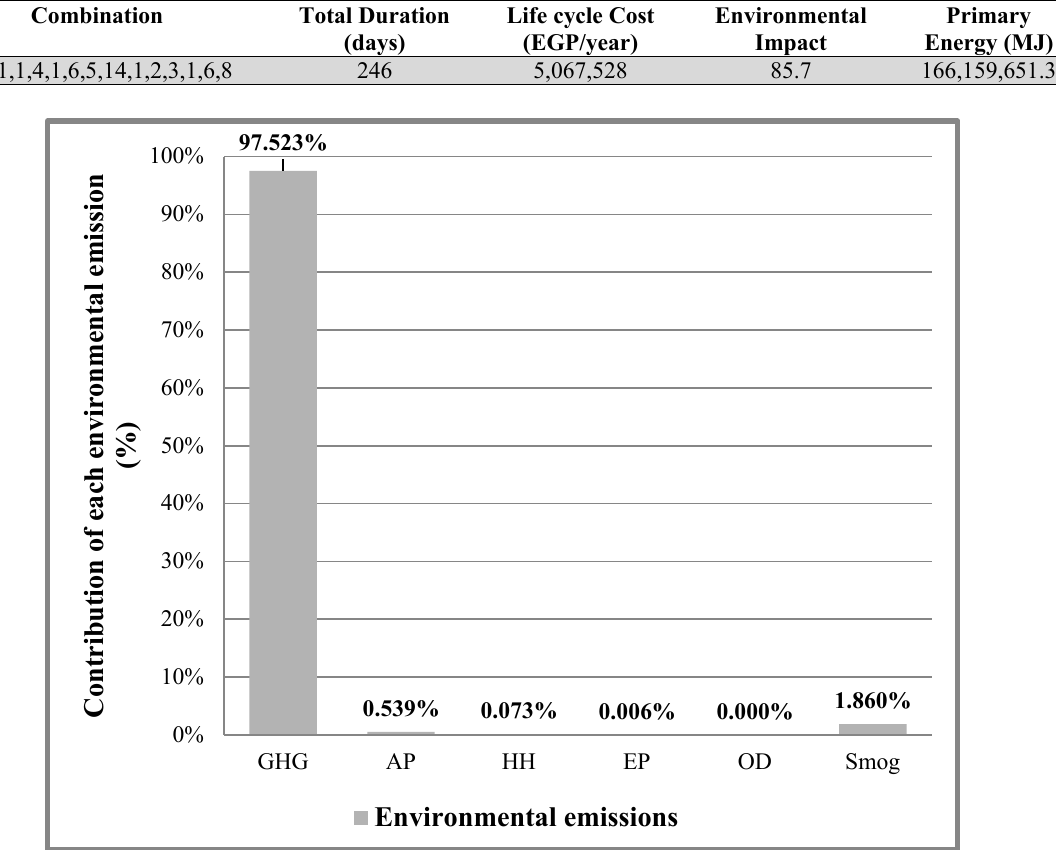
Fig. 13. Contribution of environmental emissions by